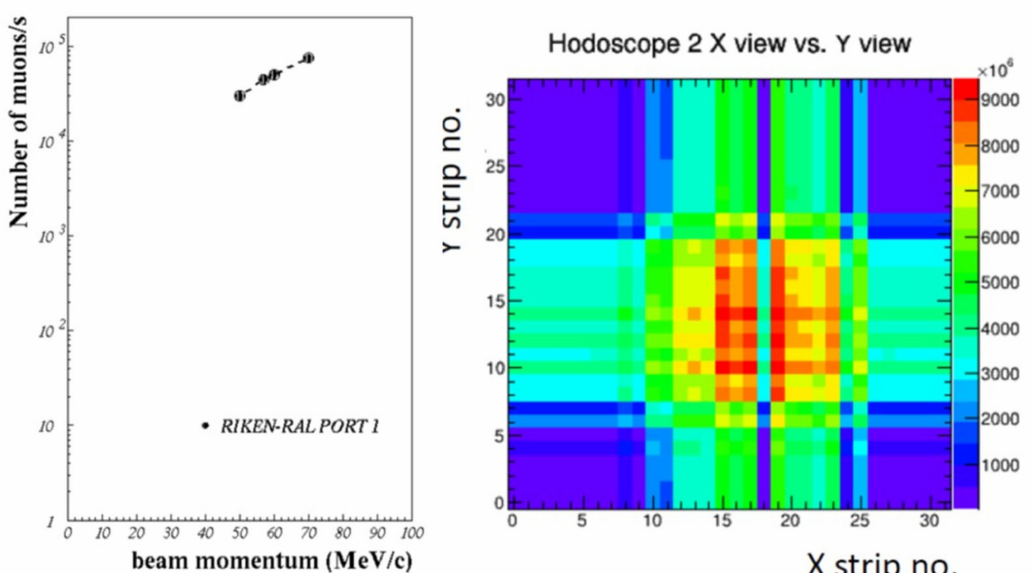
Figure 8. Left panel: Incoming muon rate per second at RiKEN RAL as estimated with one beam hodoscope. Right panel: X–Y beam profile in a typical run.